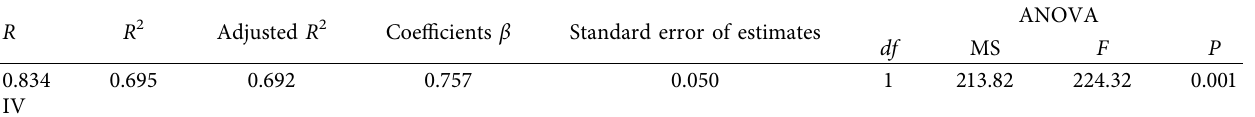
Table 6: Prediction, coefficients, and ANOVA values of performance.